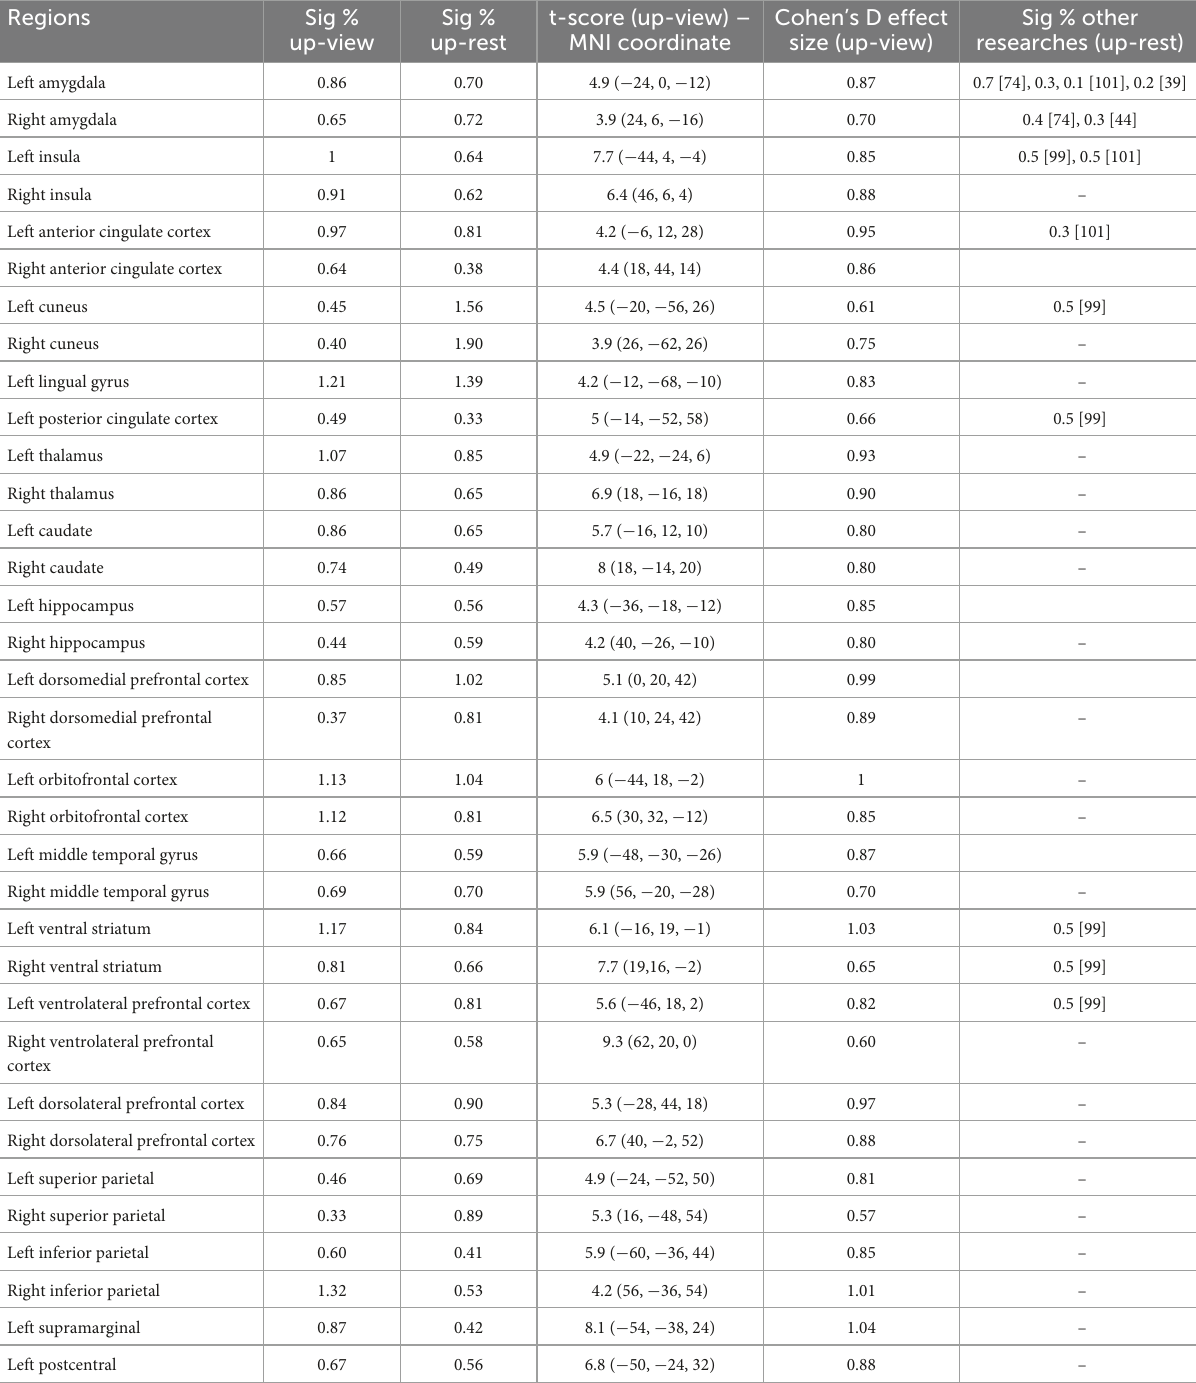
TABLE 1 Percentages of signal change, t-score, and Cohen’s D effect size for brain regions with significant signal change between Upregulation versus View and Rest in the experimental group (FDR-corrected for multiple comparison, q = 0.05). Regions Sig % Sig % t-score (up-view) – Cohen’s D effect Sig % other up-view up-rest MNI coordinate size (up-view) researches